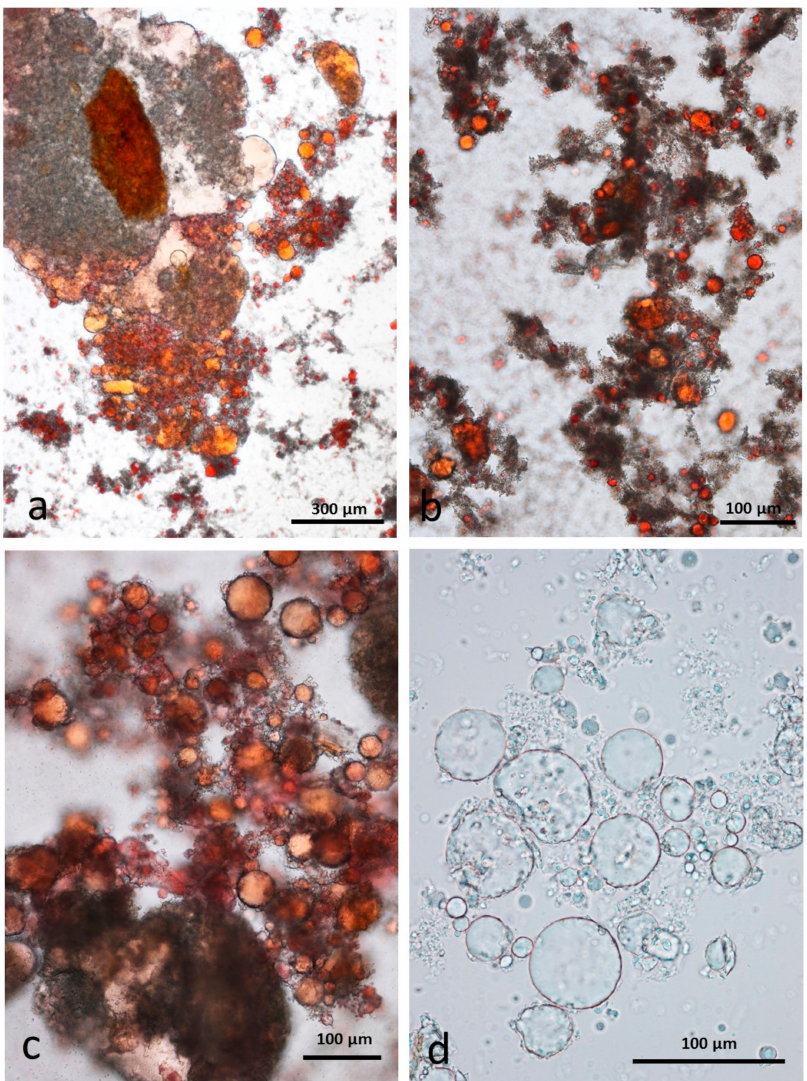
Figure 8. Chewed almond butter stored in CDTA: ( a ) blobs of oily butter containing cell fragments form in the presence of artificial saliva and escape damage from chewing; ( b ) lipid drops and adhering cell fragments released from blobs which have been broken open by chewing; ( c ) lipid drops and protein bodies are closely associated; ( d ) unstained lipid drops appear to have an internal phase but the inclusions are probably protein